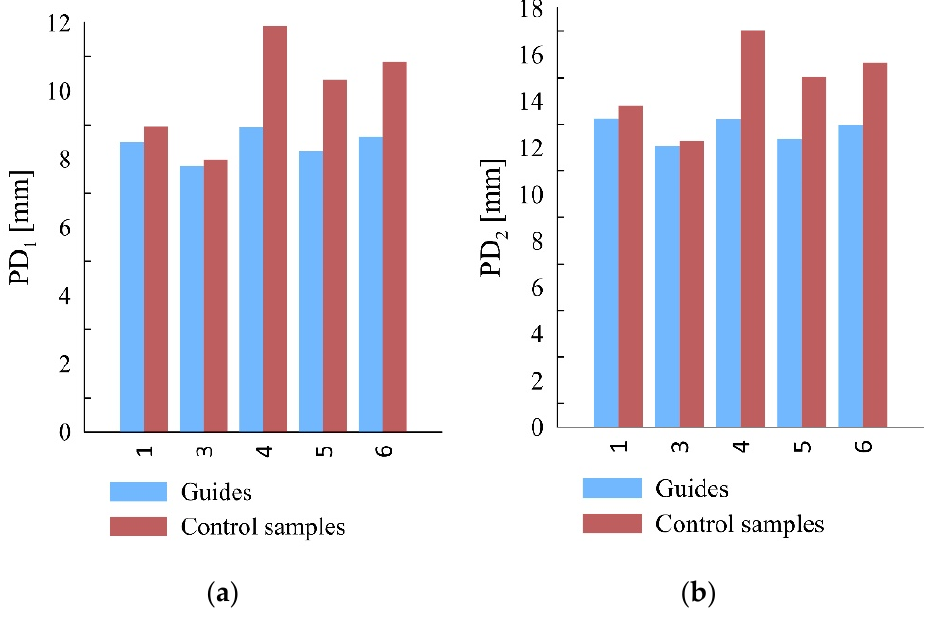
Figure 7. Comparison of sclerometric tests results of guide and reference samples; ( a ) single impact, ( b ) double impact.